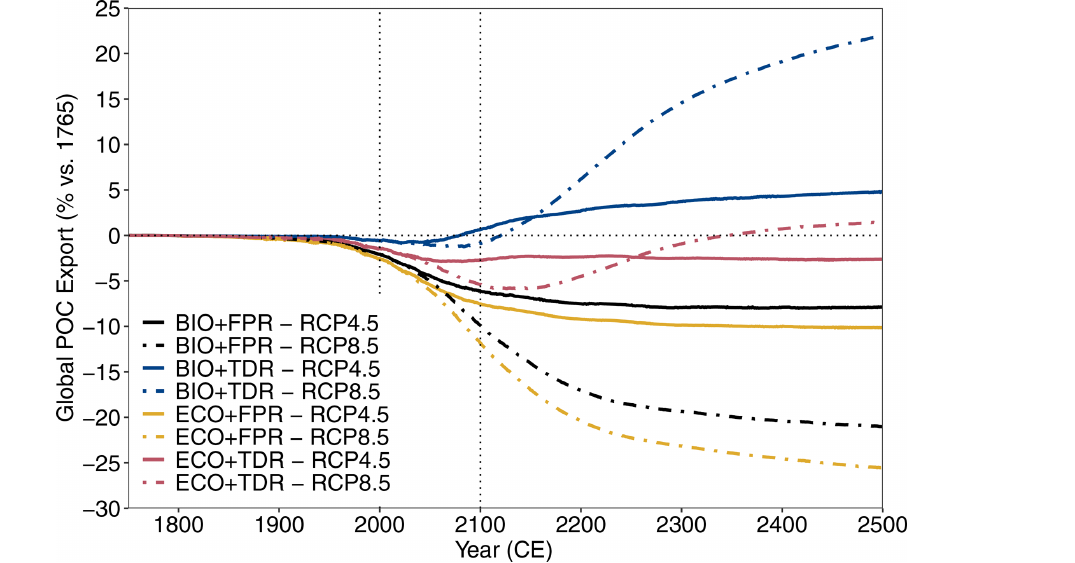
Figure 2. cGEnIE and ecoGEnIE simulation results for global POC export flux under different configurations and forcing scenarios. Results for RCP4.5 (solid lines) and RCP8.5 (dot-dashed lines) are shown for each of the configurations (BIO+FPR – black; BIO+TDR – blue; ECO+FPR – yellow; ECO+TDR – red), and the baseline POC export and the 21st century are marked by the horizontal and vertical dotted lines respectively. Results for all emission scenarios are shown in Fig. S48 in the